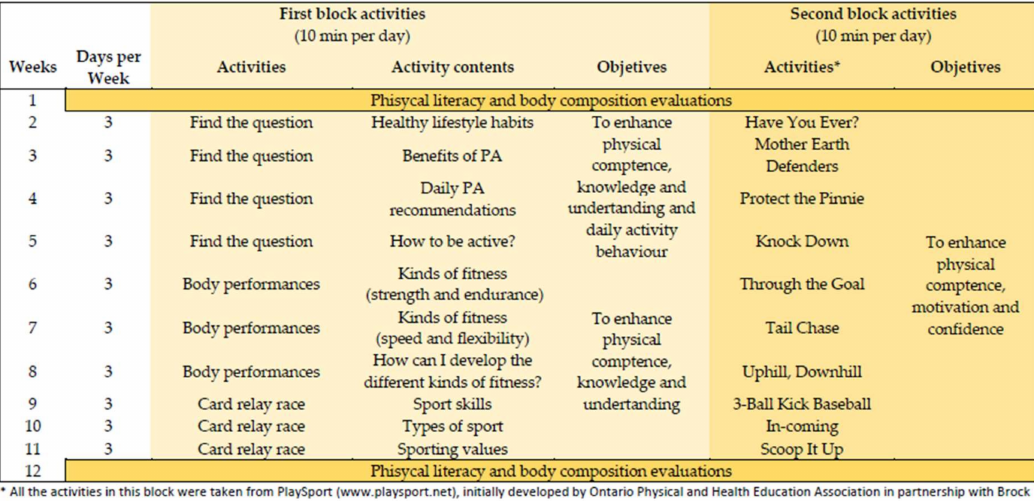
Figure 1. Activities and contents to be developed during the PLBreaks